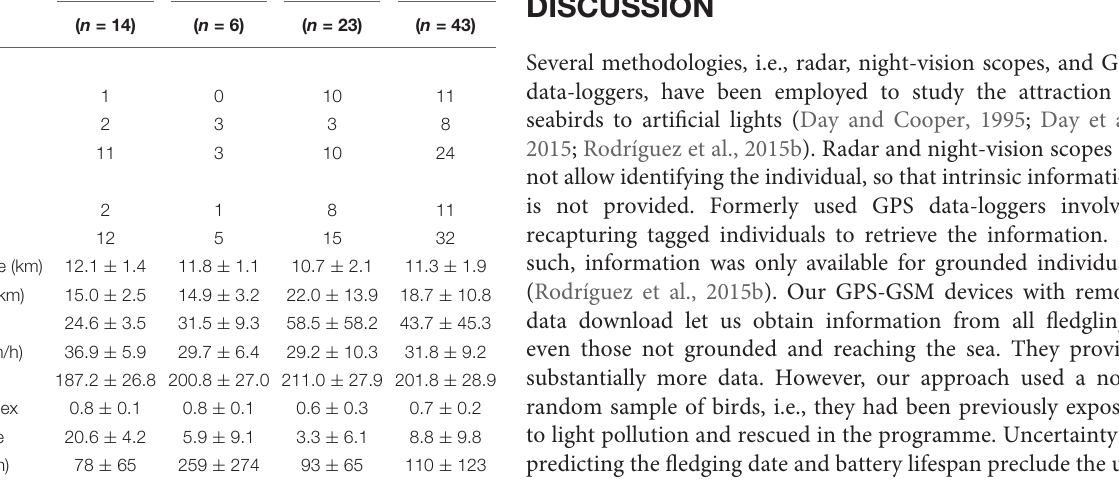
TABLE 3 | Flight descriptors (mean ± SD ) of GPS-tagged Cory’s Shearwater ( Calonectris borealis ) fledglings in Tenerife, Canary Islands, during 2017–2019.